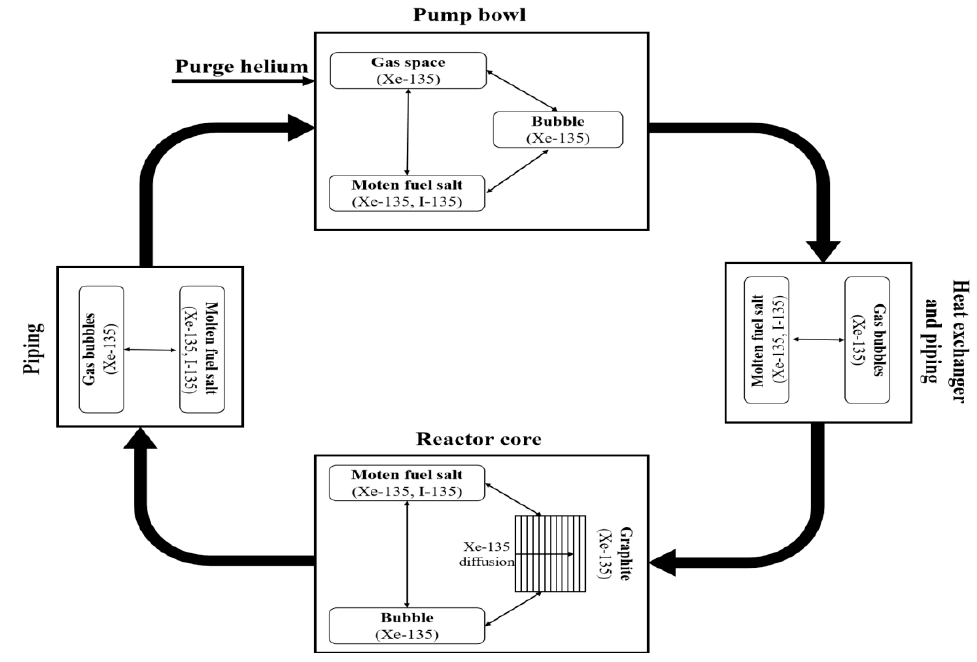
Figure 7. Modeling of 135 Xe behavior in the primary loop.